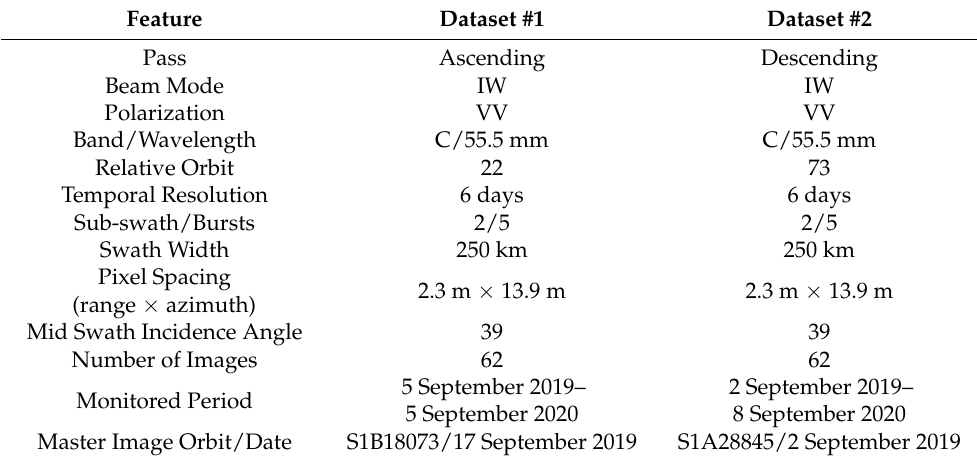
Table 1. Summary of the analyzed